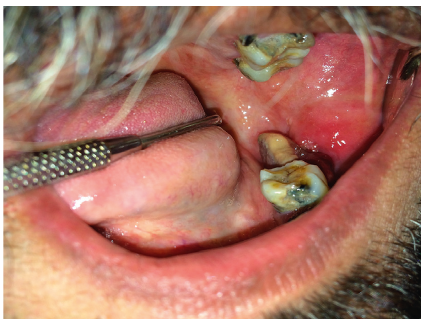
Figure 1: Clinical presentation. Intraoral examination showed a reddish white, lobular, soft gingival mass on the left mandibular alveolar ridge in the region of mandibular left third